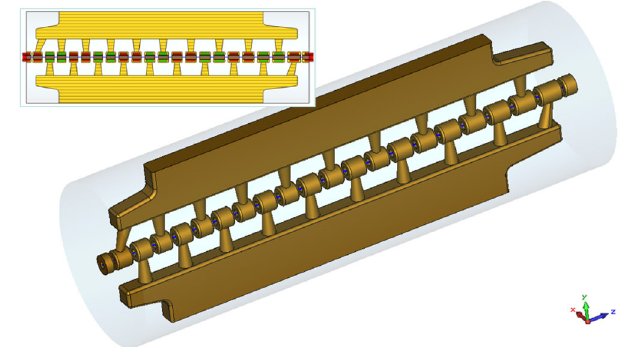
FIG. 17. MWS model of the IH1m tank with the outer wall removed. The inset shows a longitudinal vertical cross section and PMQs inside the DTs.